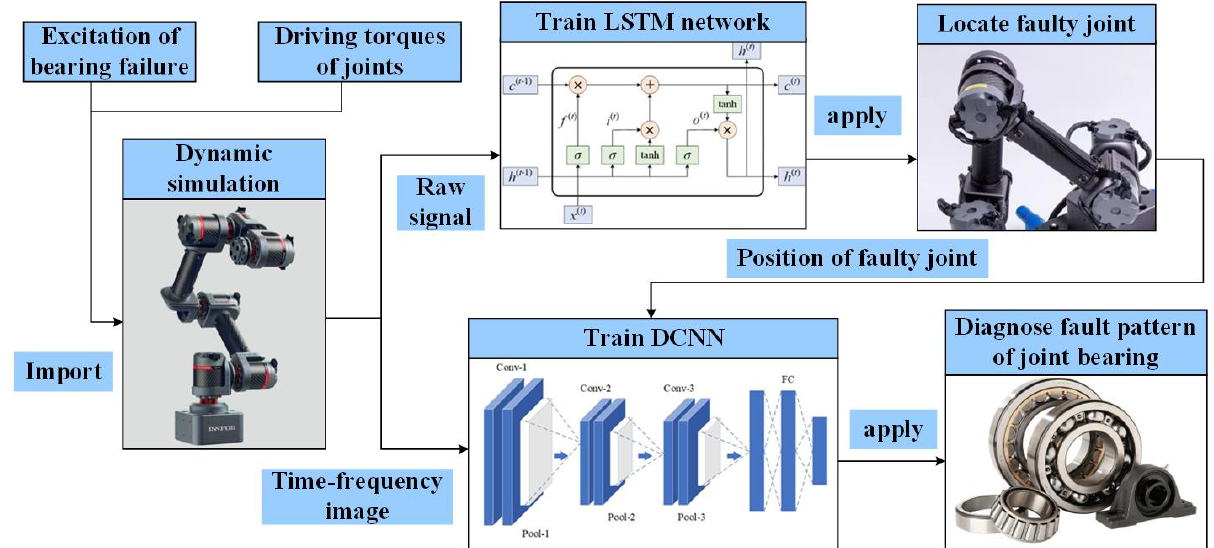
Figure 4. The workflow chart of fault diagnosis of multi-joint